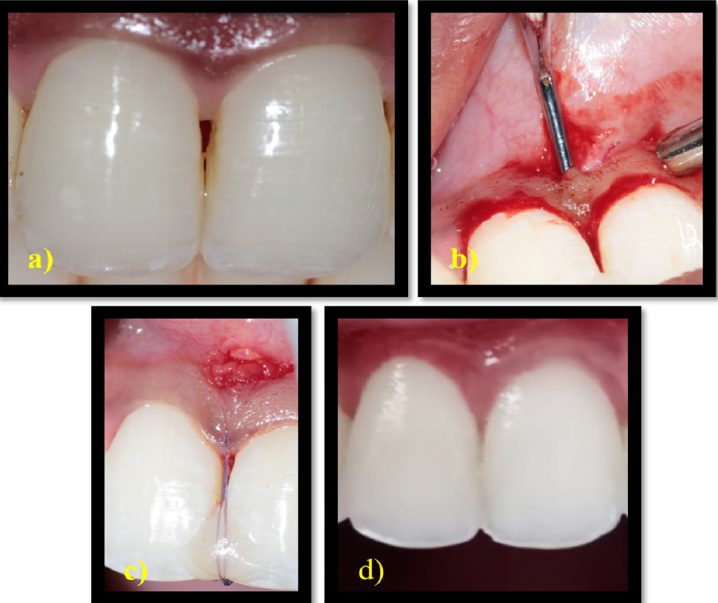
Figure 3. Surgical protocol of test group: ( a ) Preoperative image of 11 and 21 in PRF group. ( b ) Tunnel preparation in PRF group. ( c ) Vertical mattress sutures placed along the composite stopper in the PRF group. ( d ) Six months postoperative image in the PRF group. PRF: Platelet Rich Fibrin